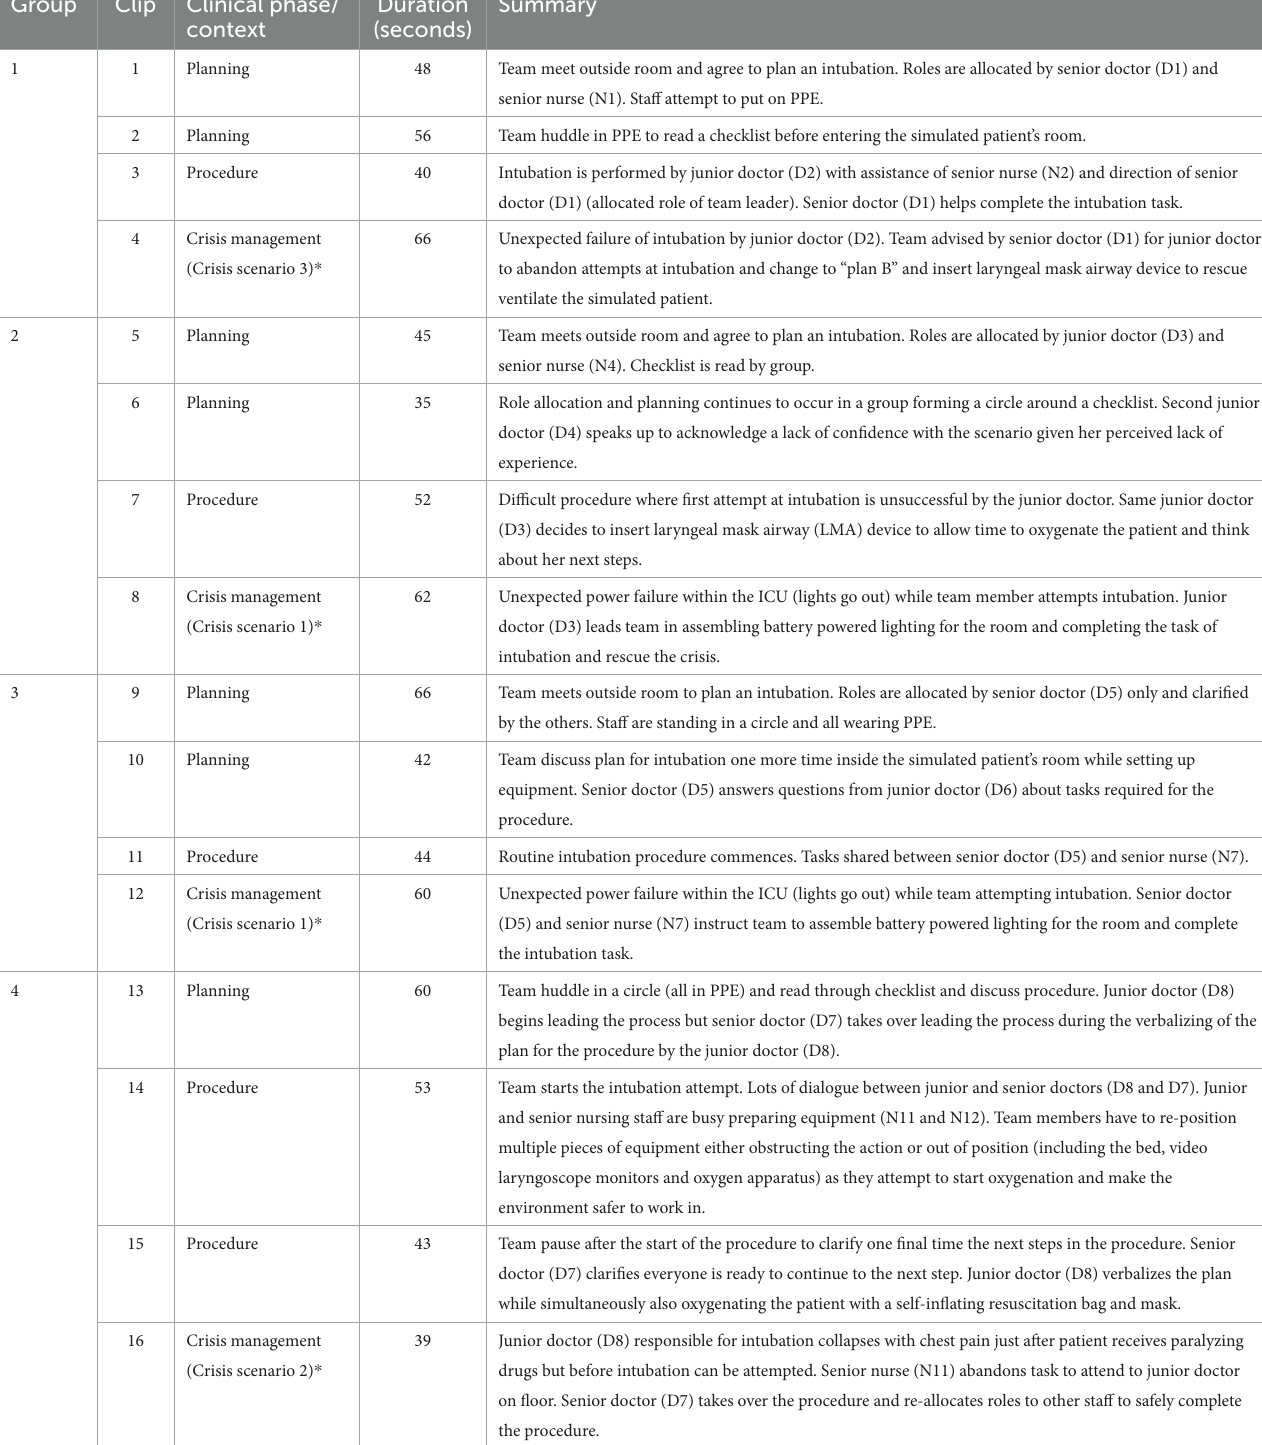
TABLE 3 A summary of video clips used for reflexivity.